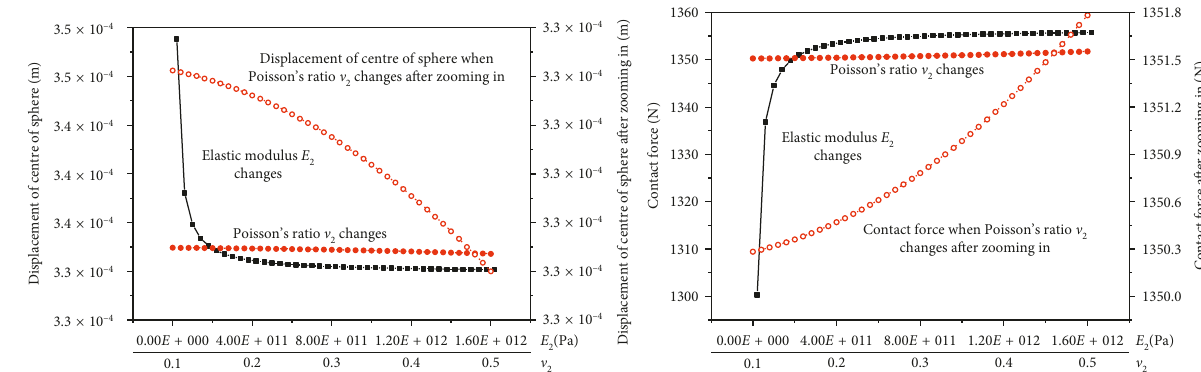
Figure 13: Effect of metal plate parameters on DCS and contact